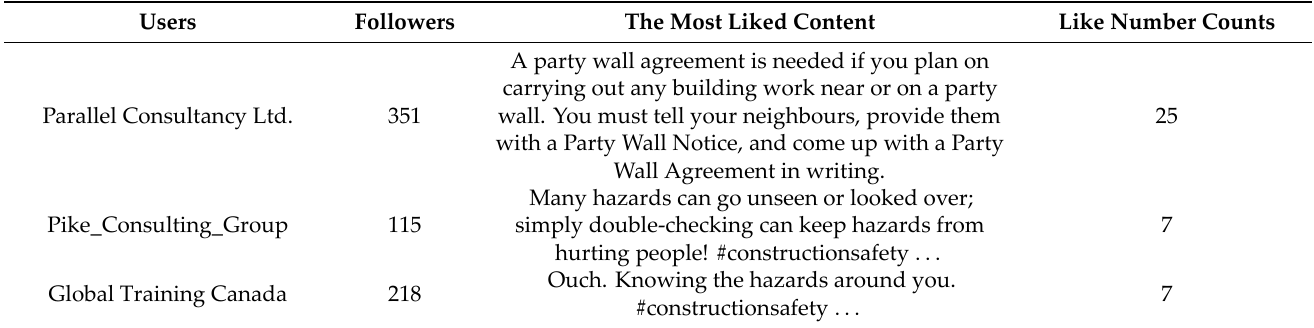
Table 4. Top 3 influential users on construction health and safety on Instagram.